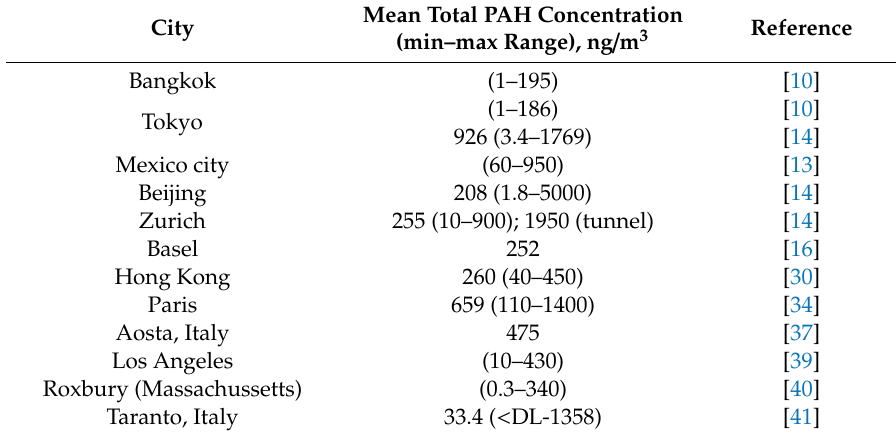
Figure 7. Real-time total p-PAH concentrations on the monitoring pathway. *: tra ffi c source description. Figure 7. Real ‐ time total p ‐ PAH concentrations on the monitoring pathway. *: traffic source description. Table 3. Average total p-PAH concentrations and the min–max range (ng / m 3 ) registered at urban sites in several cities Table 3. Average total p ‐ PAH concentrations and the min–max range (ng/m 3 ) registered at urban sites in several cities worldwide.